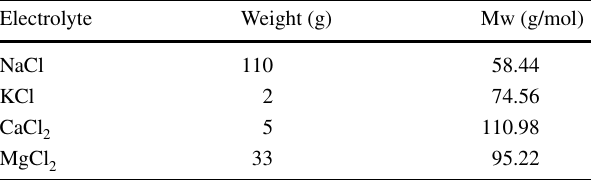
Table 3 Properties of formation water